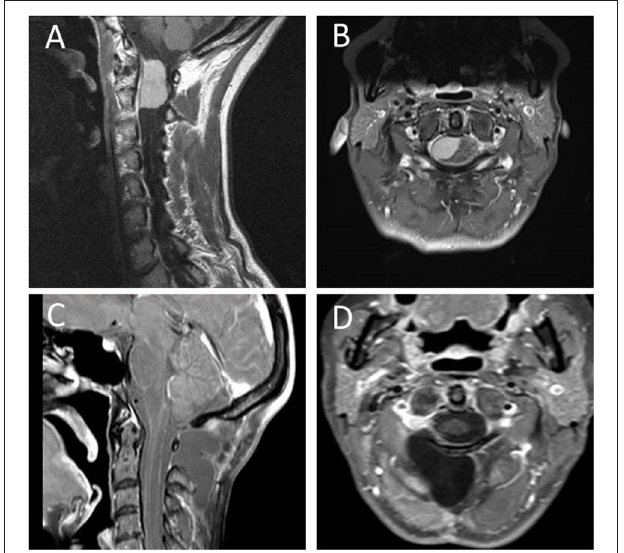
FIGURE 2 | Preoperative sagittal (A) and transverse (B) T1-weighted contrast enhanced MRI of case 1 depicting an anteriorly located meningioma of the upper cervical spine with cranial extension into the foramen magnum. Postoperative sagittal (C) and transverse (D) T1-weighed contrast enhanced MRI showing complete resection of the WHO ◦ II meningioma without the need of resecting any boney structures.